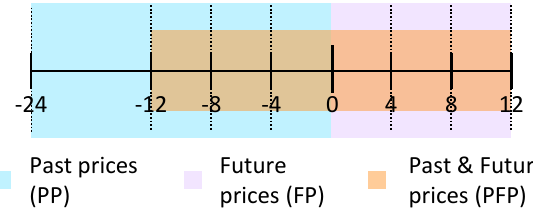
Figure 3. The time windows used to evaluate the hourly electricity prices.